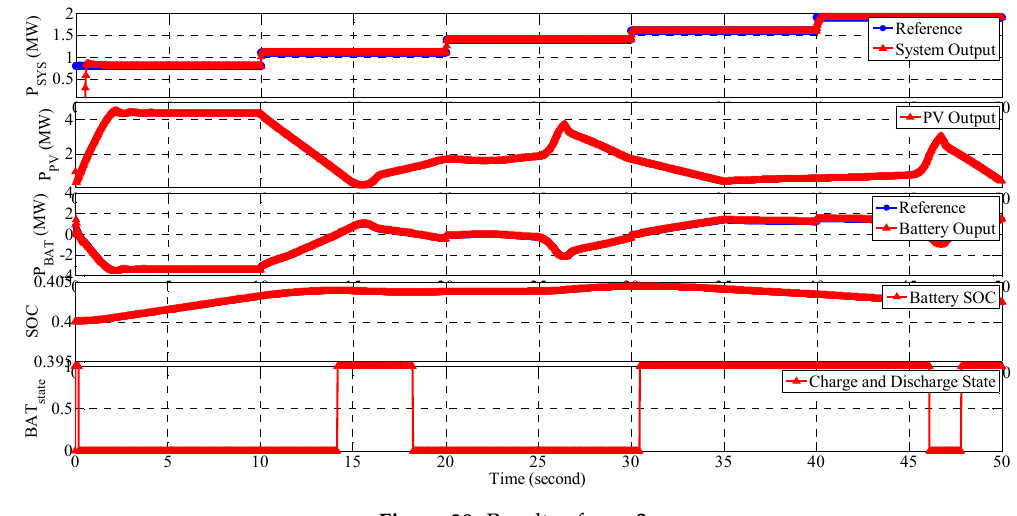
Figure 38. Results of case 2.